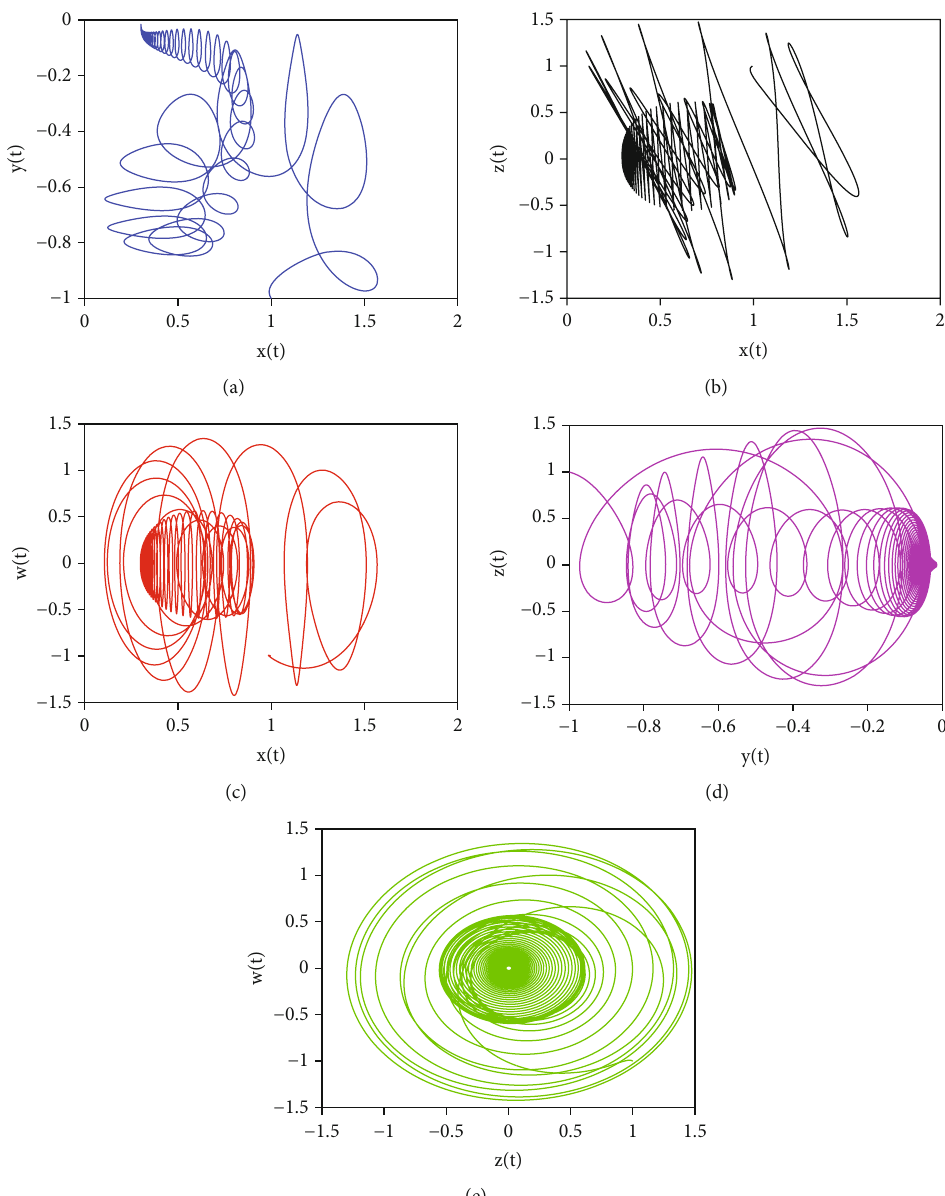
Figure 8: The behavior of di ff erent state variables of system 1 with fractional order ϖ = 0 : 99 and the parameters are considered as c = 2, d = 5